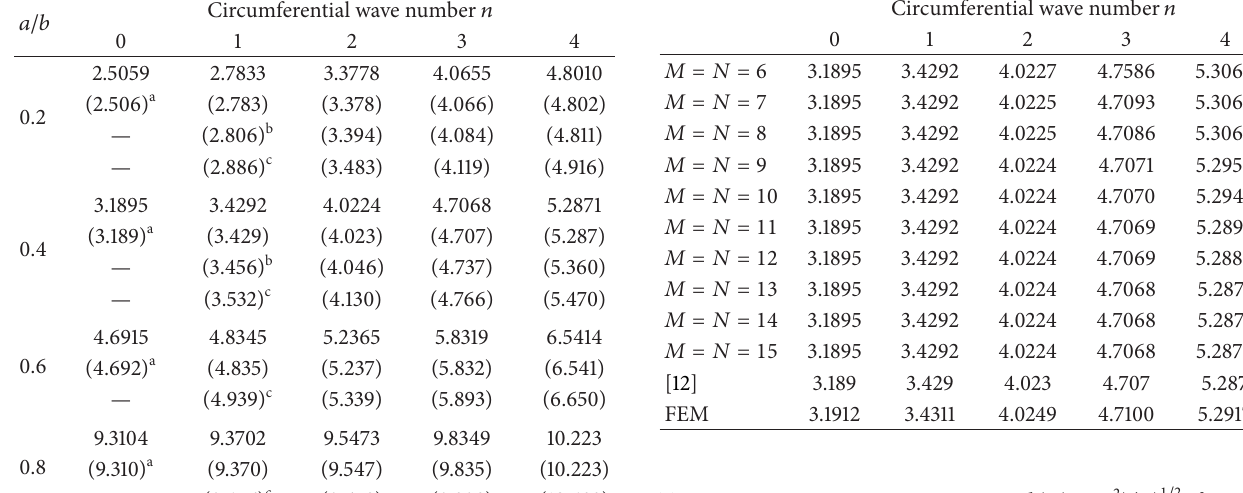
Table 3: Frequency parameters, Ω = 𝜔𝑏(𝜌(1 − V 2 )/𝐸) 1/2 , for